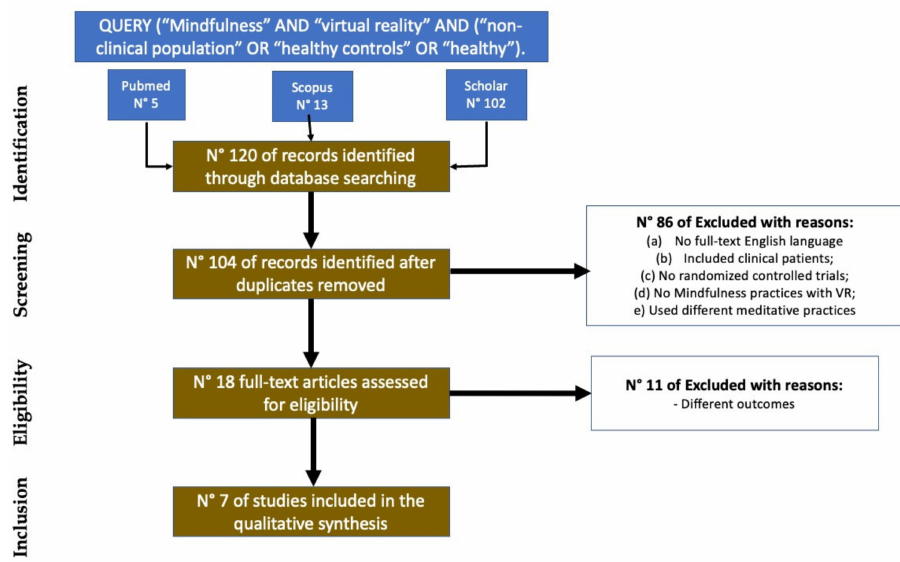
Figure 1. The PRISMA